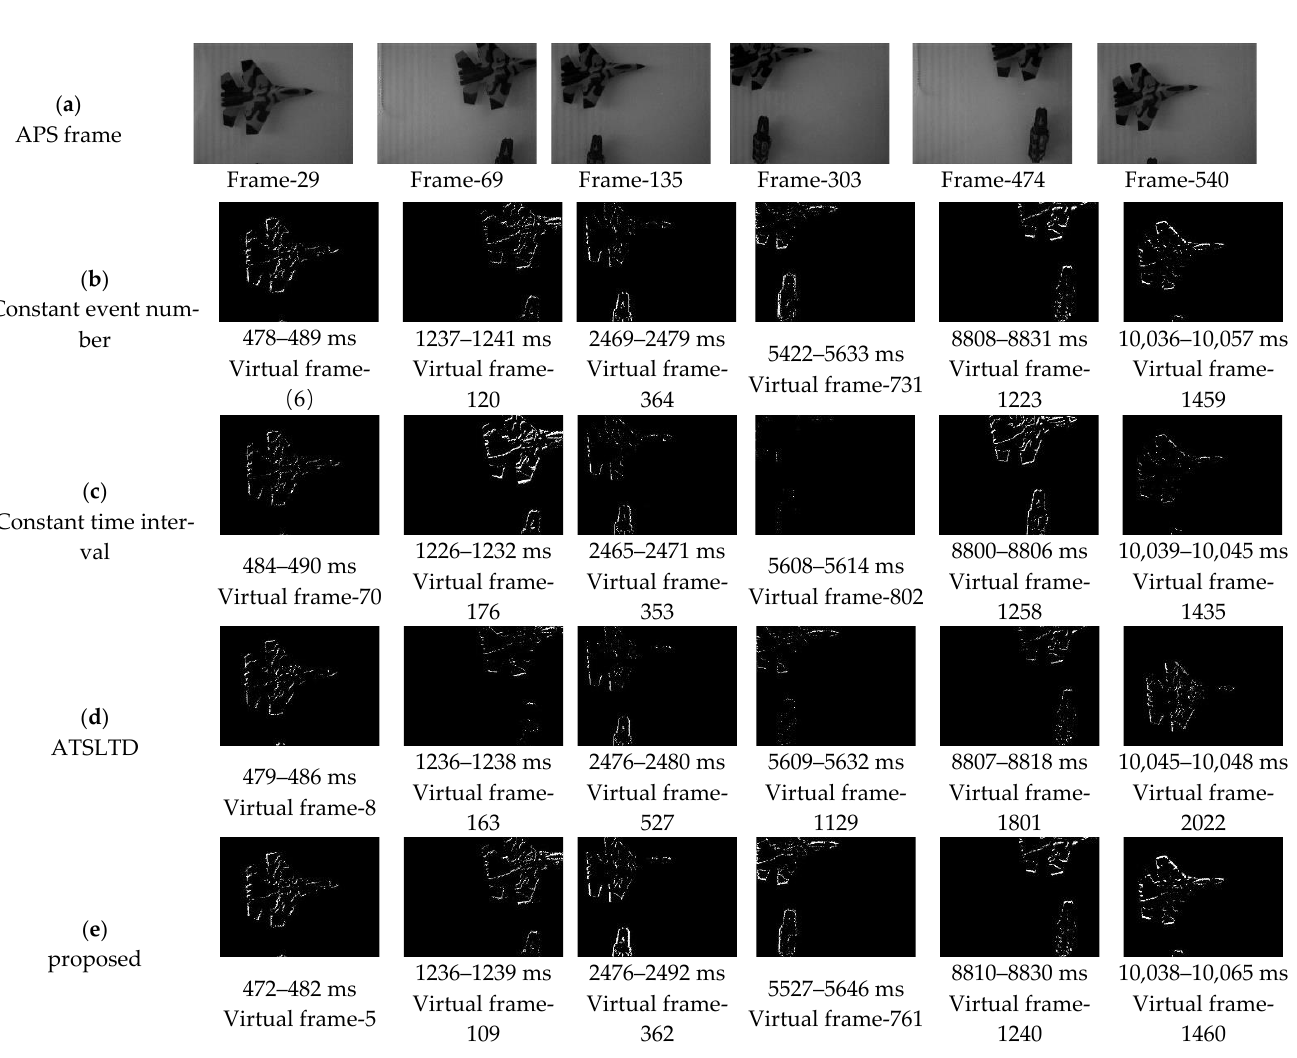
( b ) Figure 13. ( a ) The information entropy curve of virtual frame obtained by the four slicing methods and APS frame; ( b ) the difference curve between the information entropy of virtual frame obtained by the four methods and APS frame. Table 1. The mean value of the difference between the information entropy of virtual frame obtained by the four methods and APS frame. The Method